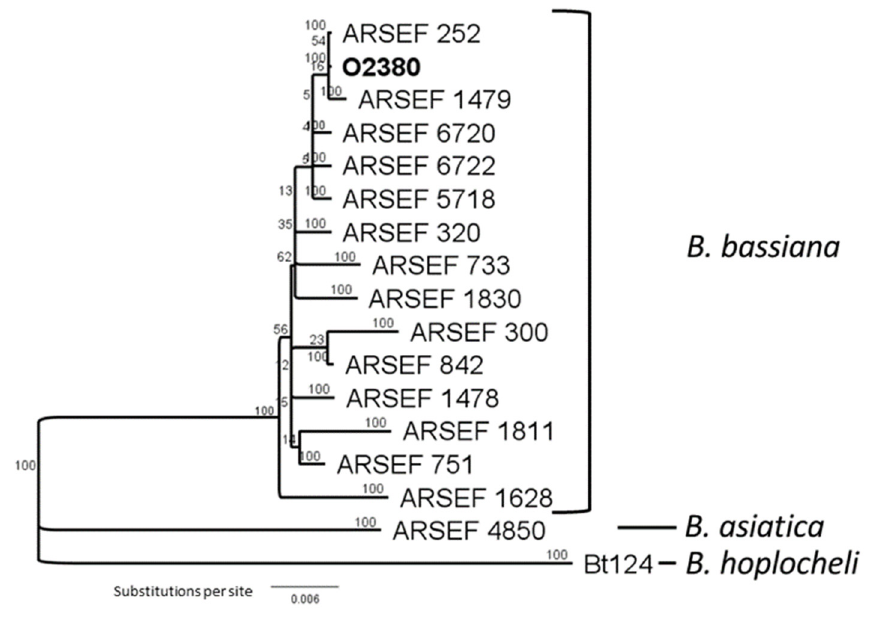
Figure 1. A phylogenetic tree comparing Be. bassiana strain O2380 isolated from Br. rapa to selected reference isolates using elongation factor sequences, including strains sequenced by Rehner & Buckley [31].